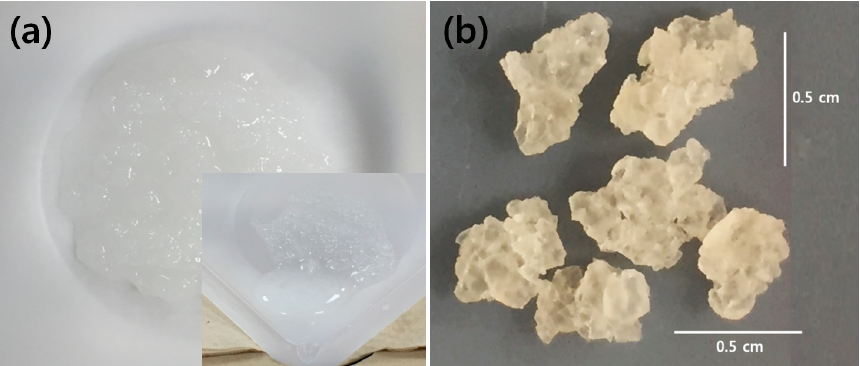
Figure 7. ( a ) Hydrated gel formed in solution extracted with 5% acetic acid, and ( b ) the dried state after mechanical filtering of ( a ).